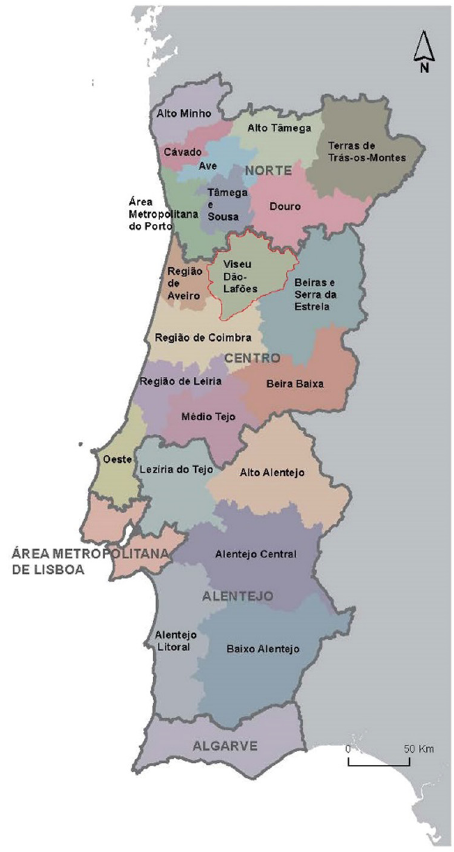
Figure 3: Localization of Viseu Dão lafões Region in Portugal, Source: INE ( 2015 )